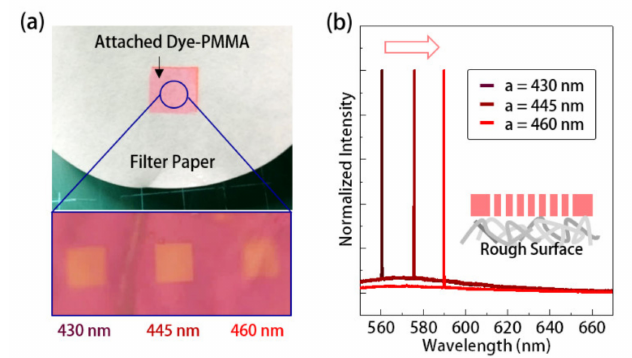
Figure 4. ( a ) Picture and OM image of 2D SPhCs thin-film dye-lasers with different lattice constants on a filter paper and ( b ) their lasing spectra.